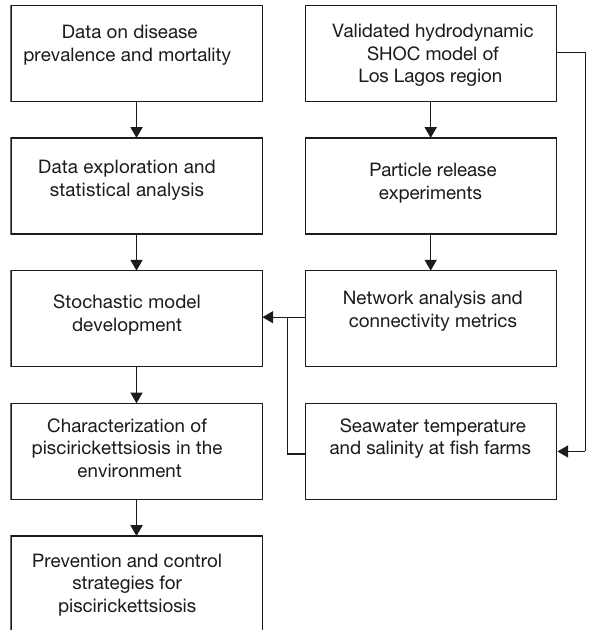
Fig. 1. Conceptual diagram of model development and appli- cation to explore environmental dependencies of piscirickett- siosis in open-cage marine salmon farms. SHOC: Sparse Hydrodynamic Ocean Code (Herzfeld